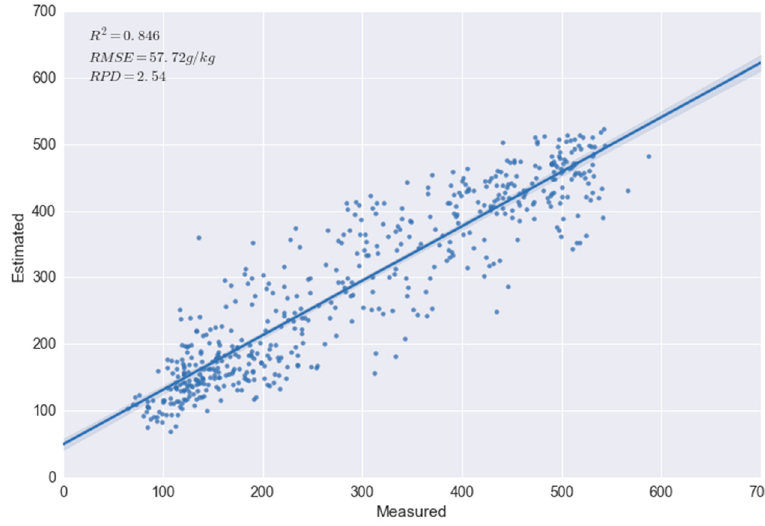
Figure 9. The gradient-boosting regression model with PLS components for the estimation of OC contents.